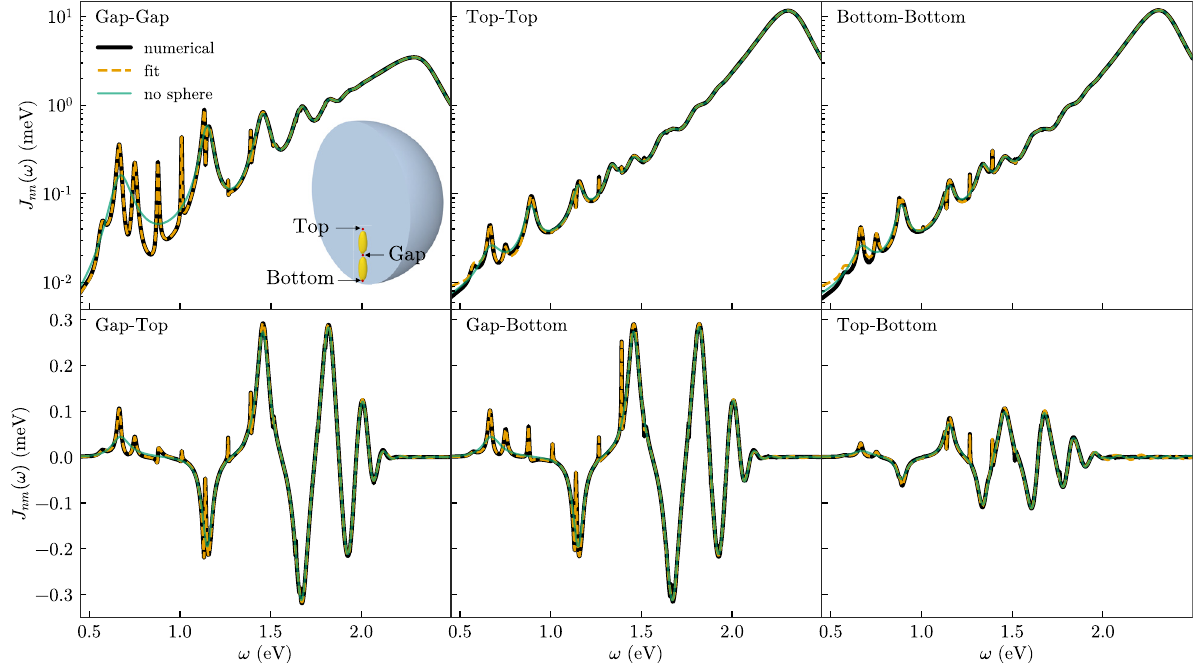
Figure 1: Generalized spectral densities for z -oriented emitters at Gap, Top and Bottom positions (thick black line), fitted model spectral density (orange line), and spectral density when the microsphere is replaced by a dielectric background (green line). Inset: Sketch of the system consisting of a silver dimer nanoantenna embedded in a dielectric microsphere (with the same dimensions as in ref. [1]). The red dots show the position of each